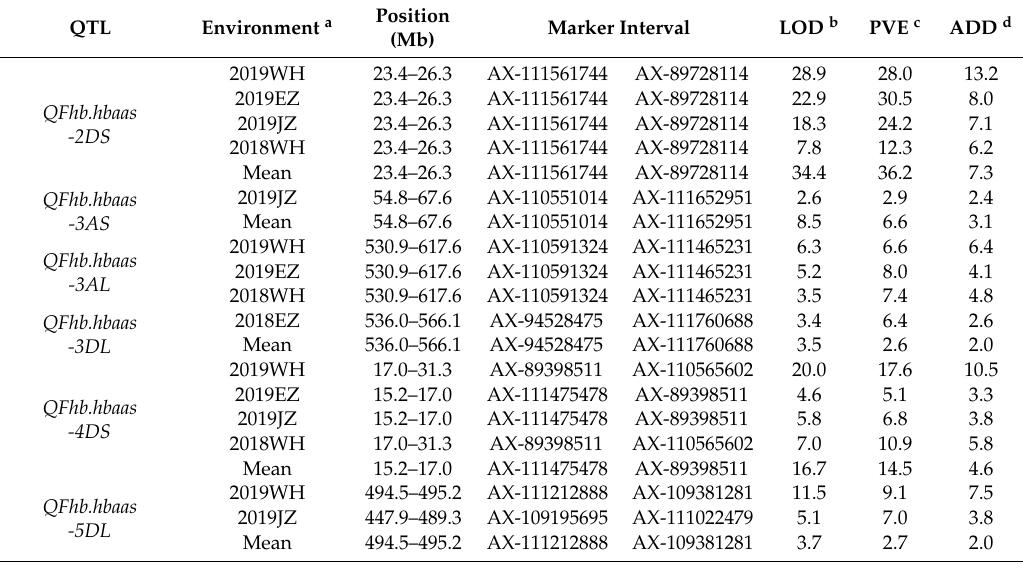
inclusive composite interval